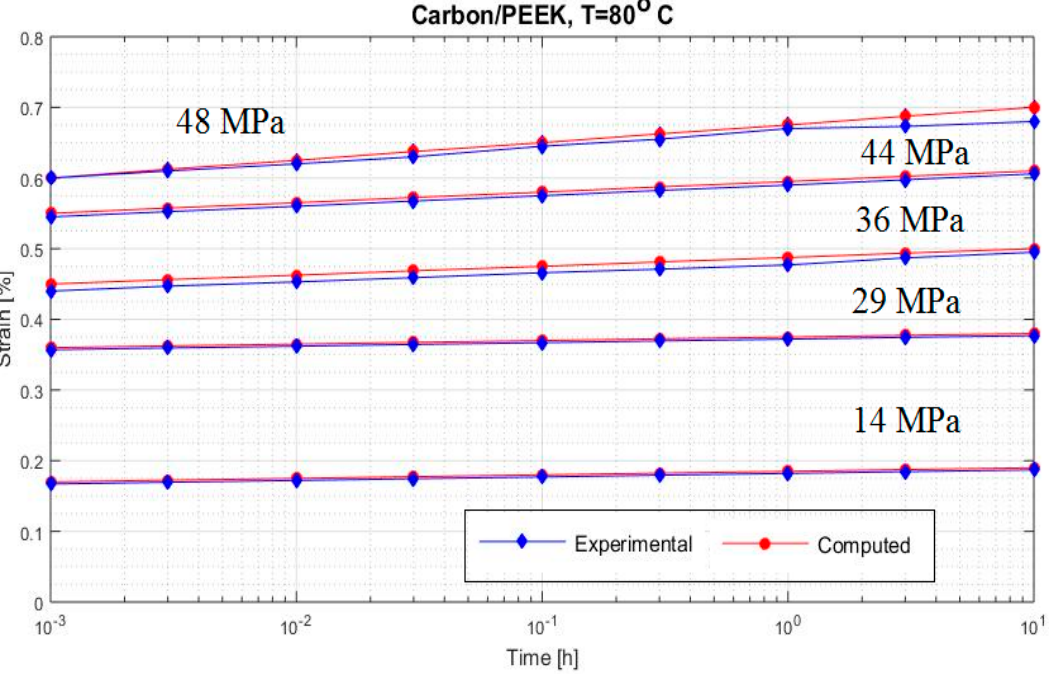
Figure 8. Creep strain ε 22 (carbon/PEEK considering different stress at 80 °C).